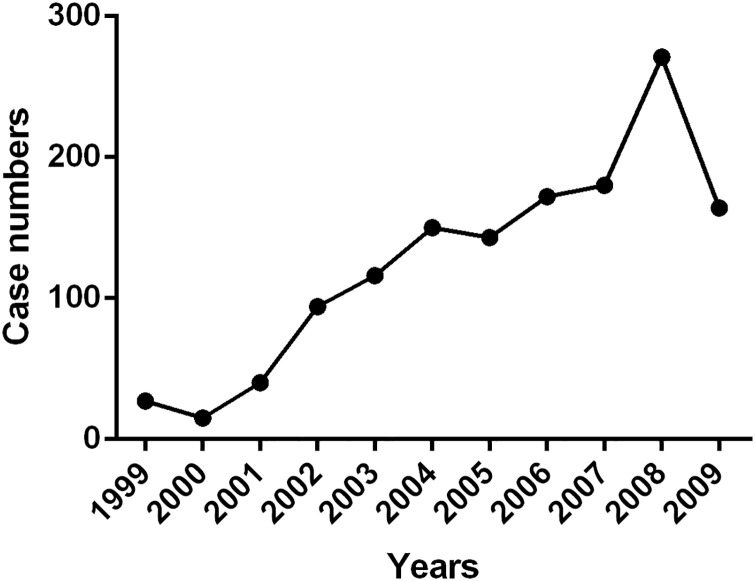
Number of SLE patients recruited each calendar year (1999–2009).